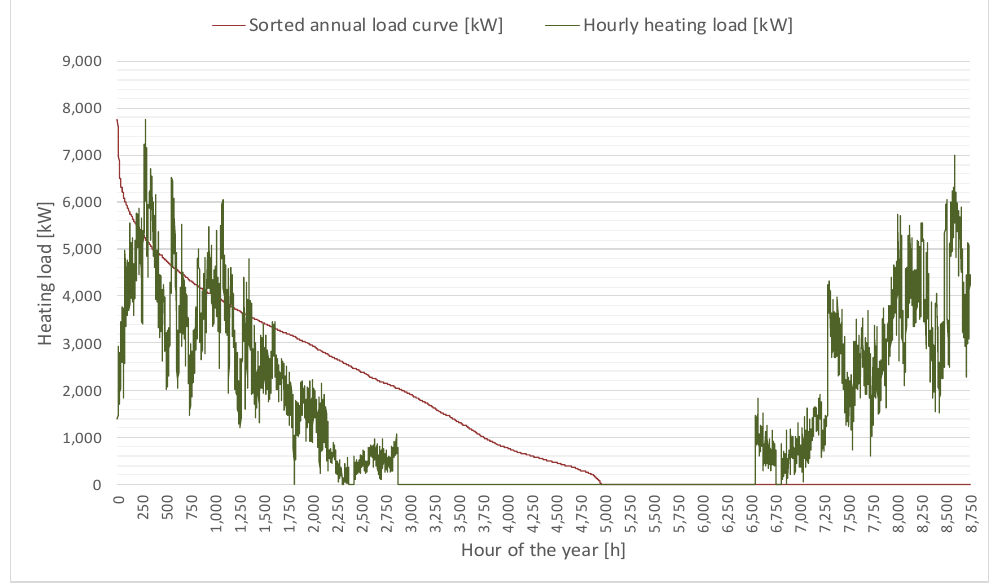
Figure 6. Sorted annual heat load curve (red) and hourly heat load (green) for Walheim (EnEV